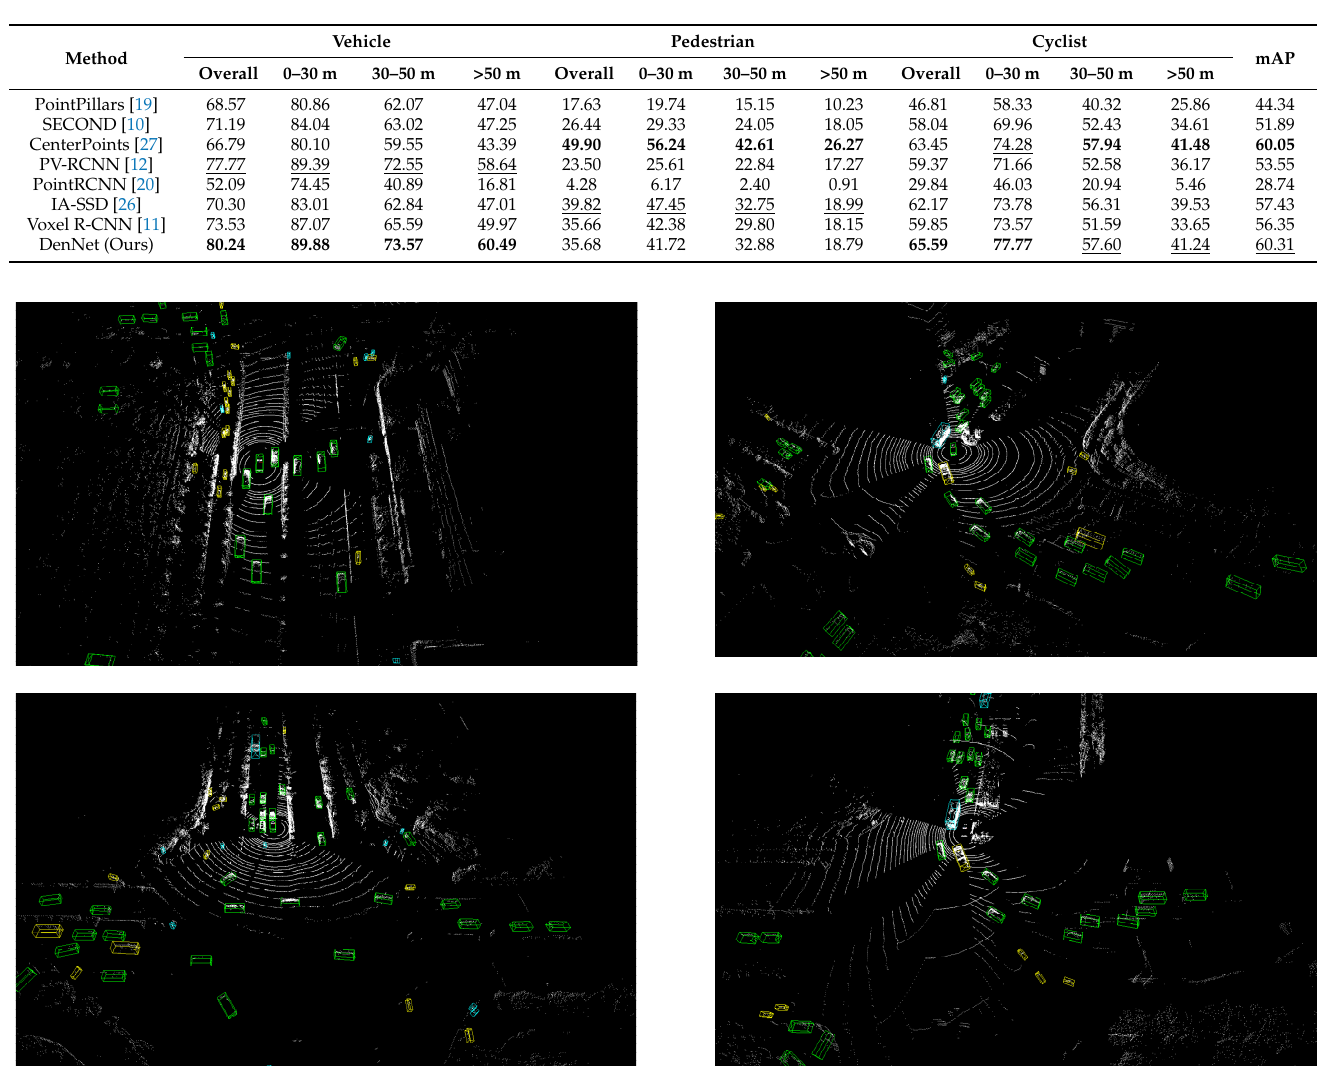
Table 4. Ablation study on ONCE validation